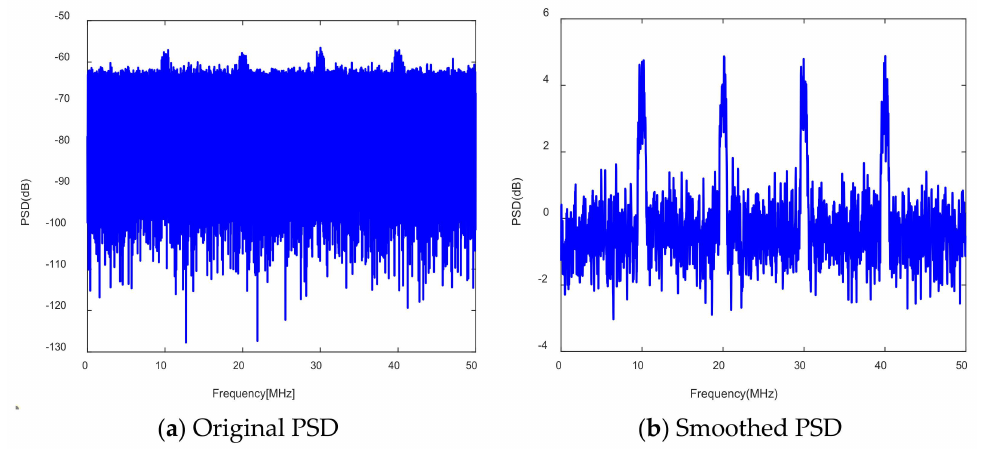
Figure 7. PSD estimation